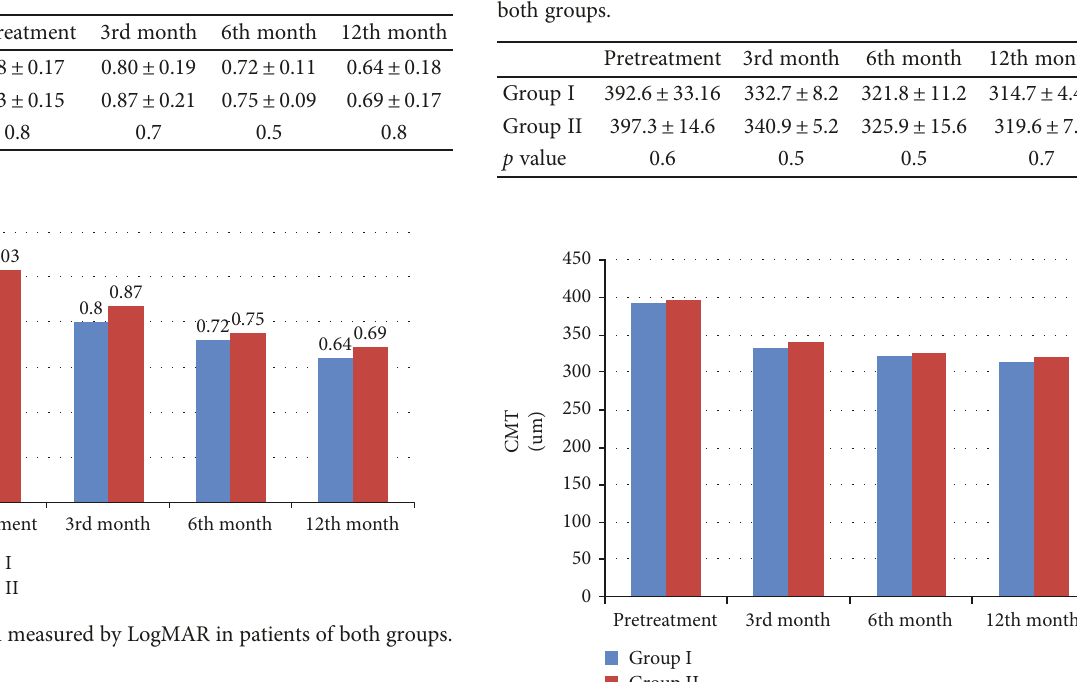
Table 1: BCVA (LogMAR) in both